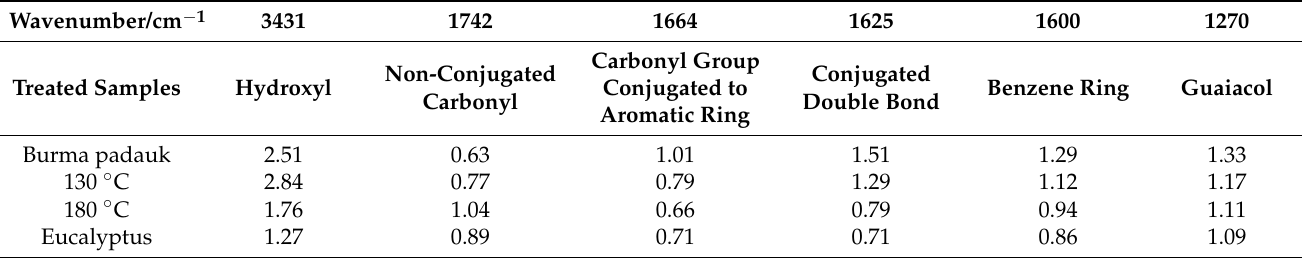
Figure 3. FTIR spectra of Eucalyptus and Burma padauk wood. Burma padauk (red line); 130 ◦ C saturated steam treatment (blue line); 180 ◦ C hot air treatment (green line); control sample Eucalyptus (black line). Table 1. Change in relative peak height of FTIR for Eucalyptus and Burma padauk wood.